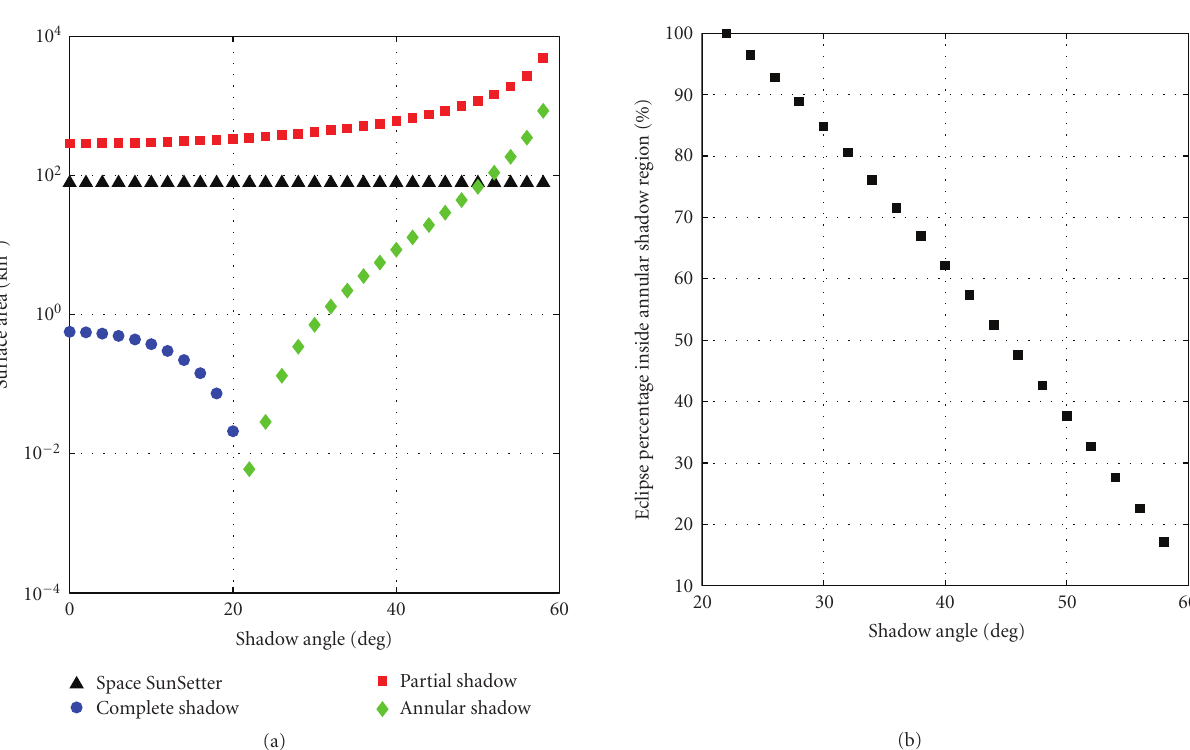
Figure 5: Space SunSetter with a radius of 5 km at 1000 km